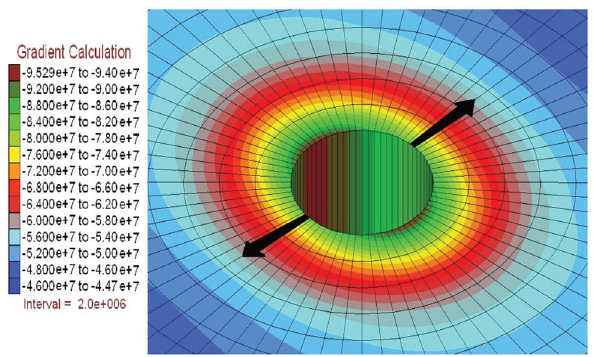
Fig. 7 To form a hydraulic fracture based on the distribution of ten- sions around the